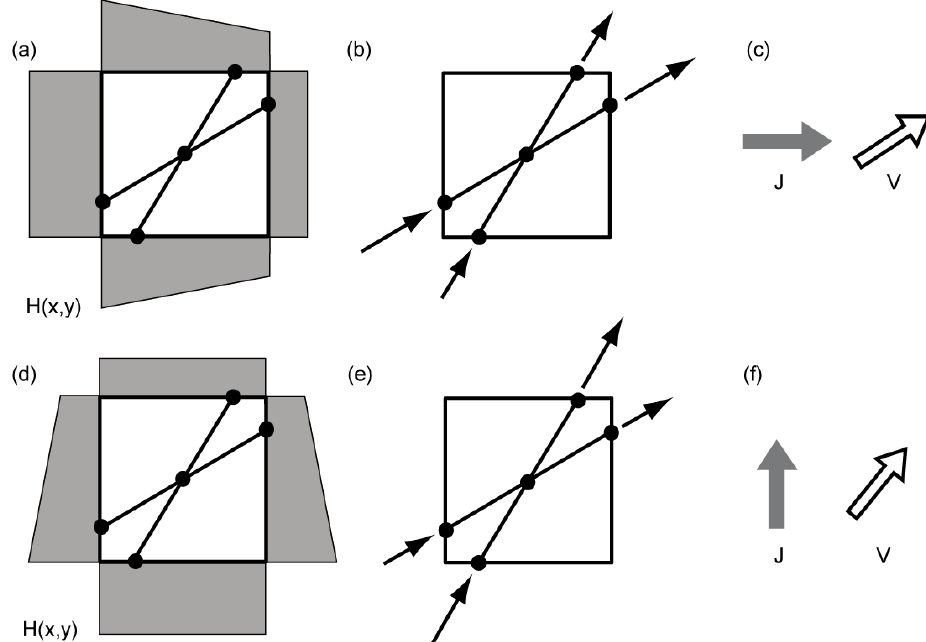
Figure 22. Schematic of a fracture network and the Darcy velocities corresponding to a flow experiment with a prescribed horizontal gradient ( a – c ) or a prescribed vertical gradient ( d – f ). Figures ( a , d ) represent the network and the two sets of boundary conditions. Figures ( b , e ) represent the velocity vectors in the individual fractures. Figures ( e , f ) represent the prescribed mean gradient and the resulting mean velocity. In both cases, the Darcy velocity is deviated toward the principal direction of anisotropy, which is oriented at 45 degrees.